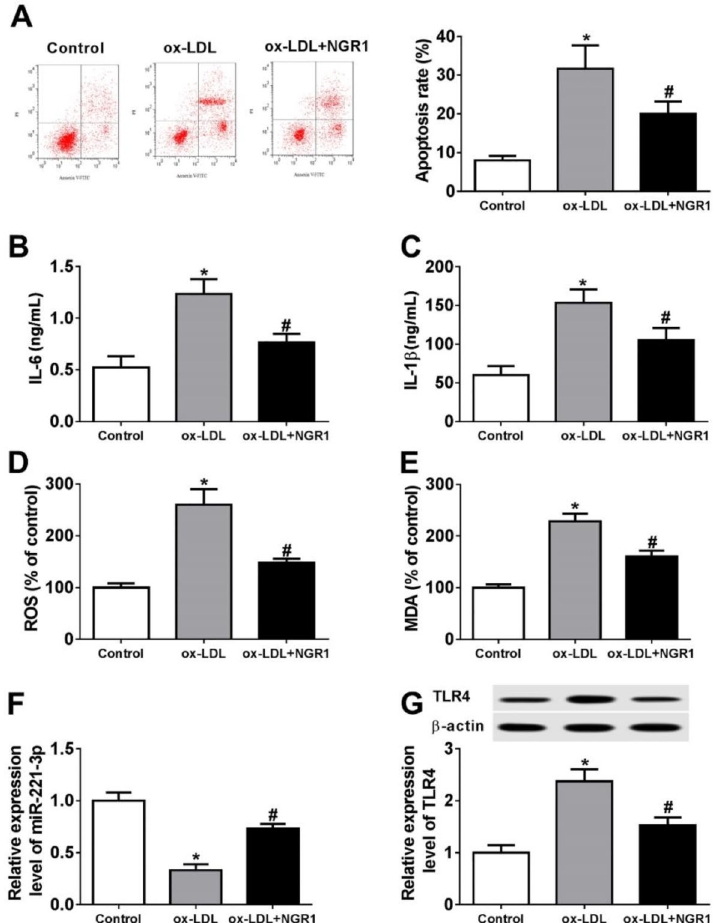
Figure 1. NGR1 alleviated oxidized low-density lipoprotein (ox-LDL)-induced apoptosis, in fl ammation, and oxidative stress in induced human umbilical vein endothelial cells (HUVECs). HUVECs were pretreated with or without 30 m M NGR1 for 24 h, followed by exposure to 50 mg/L ox-LDL. A , Flow cytometry was performed to evaluate cell apoptosis in HUVECs. B and C , ELISA assay was employed to examine the levels of in fl ammatory cytokines interleukin (IL)-6 and IL-1 b . D and E , The levels of oxidative stress markers reactive oxygen species (ROS) and malondialdehyde (MDA) were determined by assay kits. F , MiR-221-3p expression was measured by qRT- PCR. G , TLR4 protein level was detected using western blot analysis. Data are reported as means ± SD from three independent experiments. *P o 0.05 compared to control; # P o 0.05 compared to ox-LDL